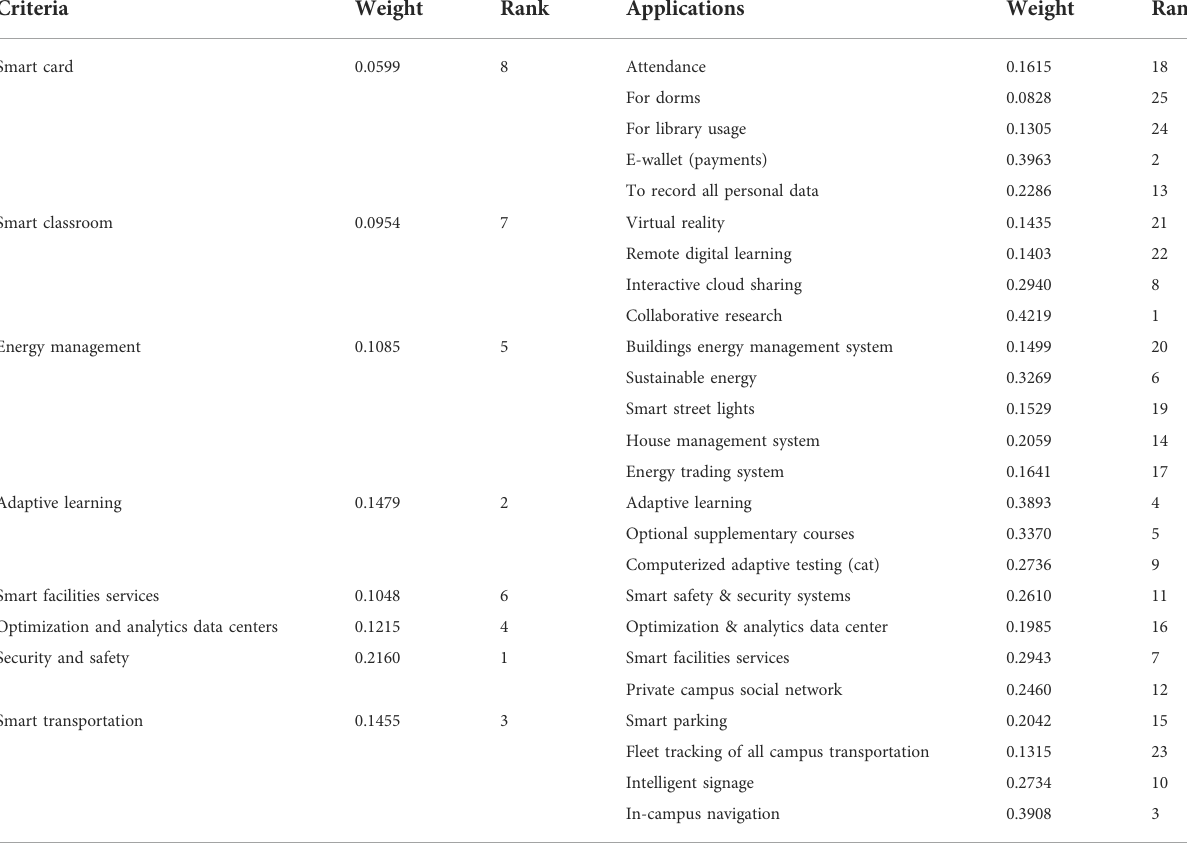
TABLE 3 Student ’ s perception regarding signi fi cant smart campus